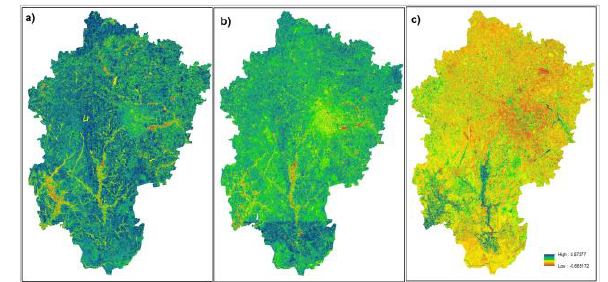
Figure 11: BMR Built up index of a) 2001 b) 2011 c)